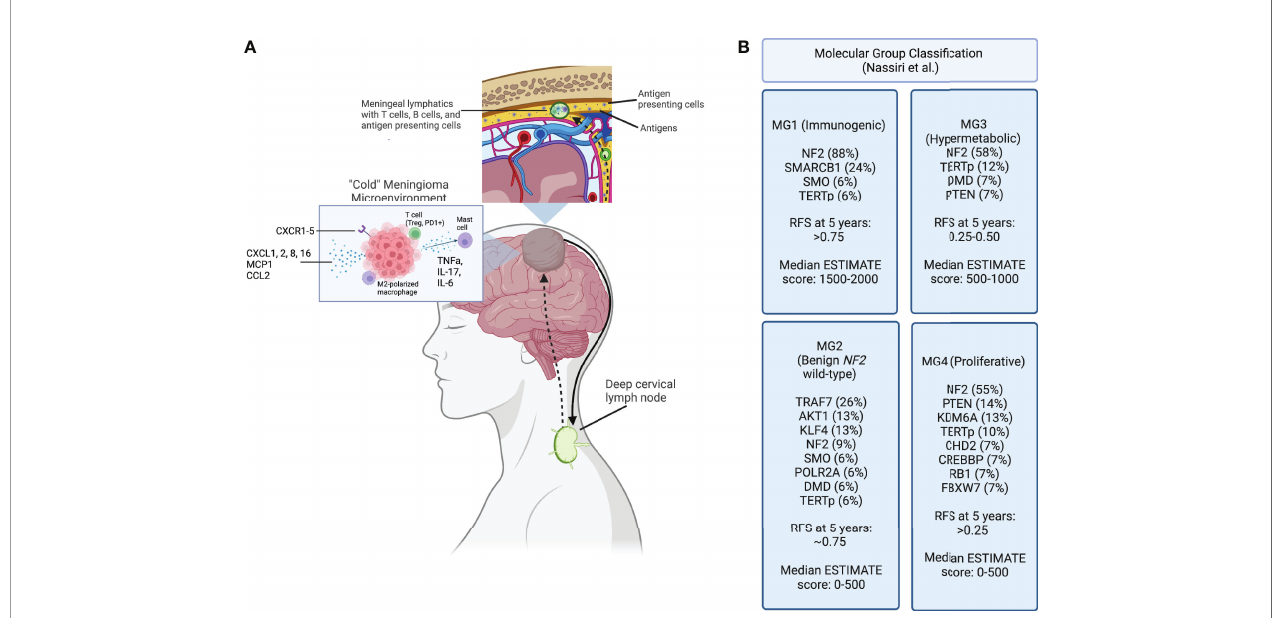
FIGURE 1 | (A) Meningioma tumor antigens are taken up by antigen presenting cells and carried to the meningeal lymphatic system, which drain to the deep cervical lymph node. After antigen presentation and immune activation occurs in the lymph node, immune cells are traf fi cked to the tumor site. A “ cold ” meningioma microenvironment consists of immunoregulatory cytokines, and immunosuppressive cell populations such as M2 polarized macrophages and regulatory T cells. (B) Molecular classi fi cation schema developed using a multimodal characterization approach by Nassiri et al., including the most frequently point-mutated genes within each category. Recurrence-free survival (RFS) at 5 years and the ESTIMATE score, quantifying immune in fi ltration based on expression of genes, are reported for each group. Created with